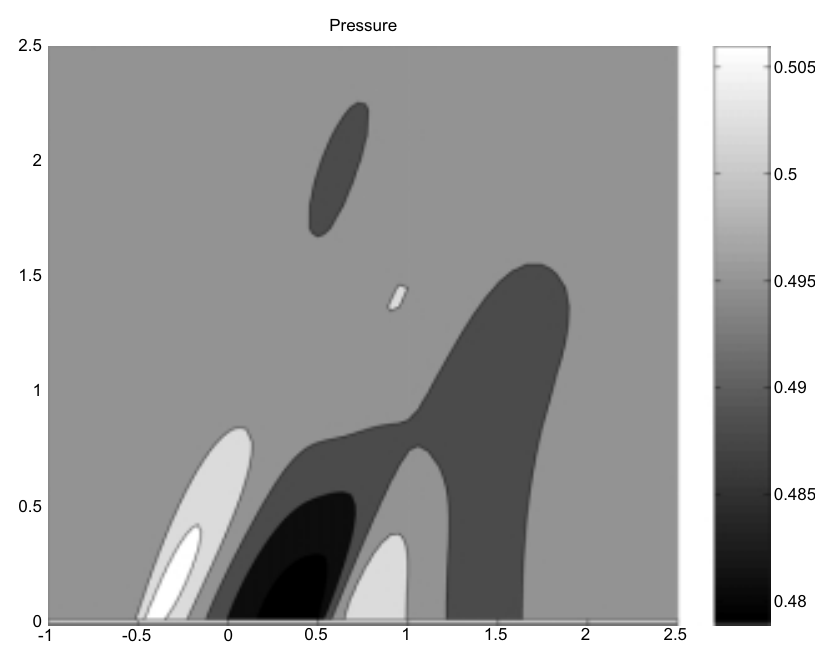
Fig. 13. Pressures after 20 second simulation, full model with δ 1 = 0 . 005 .